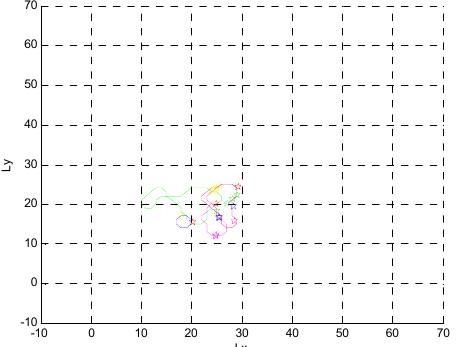
Figure 8. RL search of the v-shaped formation.